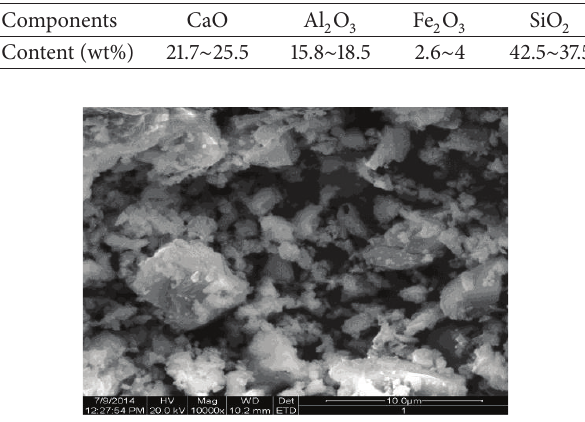
Table 4: Chemical composition of CWCPM.